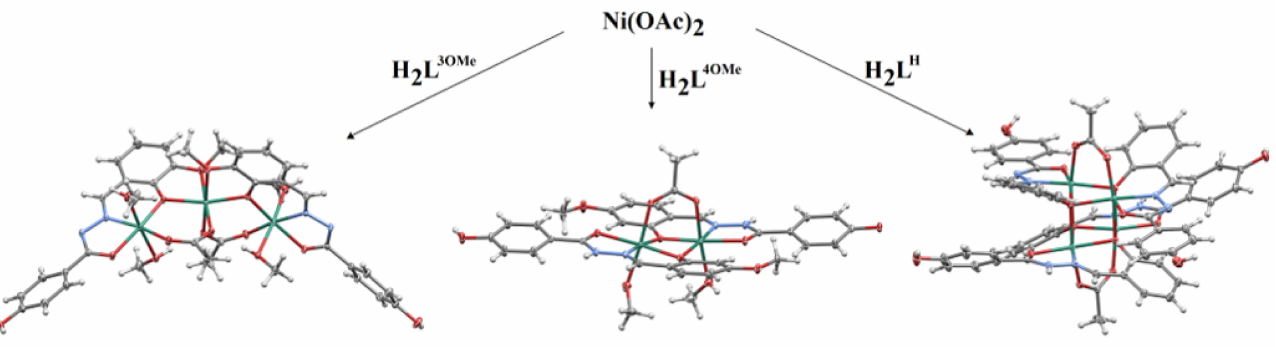
Scheme 1. Color code: Ni-green, N-blue, O-red, C-gray,